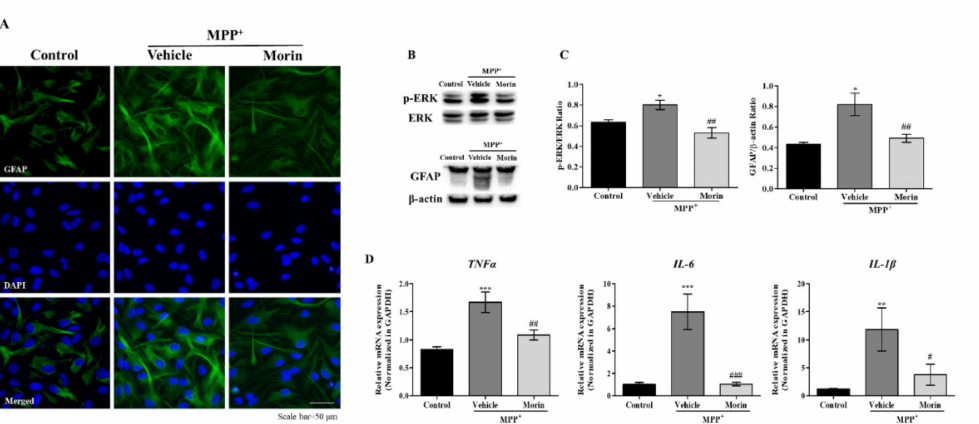
Figure 5. Morin effectively suppressed the effects of glial activation on astrocytes. ( A ) Representative images showing that morin diminished GFAP fluorescence intensity (an astrocyte marker). Cells were counterstained with DAPI. ( B ) Western blot showed that morin repressed MPP + -induced ERK phosphorylation and glial activation in primary astrocytes ( n = 3). ( C ) Quantitative densitometric analysis of Western blots. β -Actin was used as a loading control. Data are presented as means ± SEMs. * p < 0.05 vs. control, ## p < 0.01 vs. vehicle ( D ). Real time-PCR showed that morin significantly reduced MPP + -induced inflammatory cytokines level increases. Data are presented as means ± SEMs. *** p < 0.001 and ** p < 0.01 vs. control, ### p < 0.001, ## p < 0.01 and # p < 0.05 vs. vehicle.